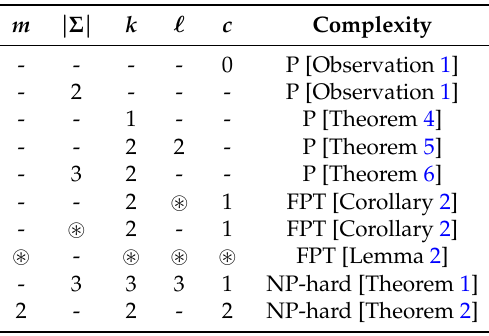
Overview of results for ( k , (cid:96) ) -C O -C LUSTERING ∞ with respect to various